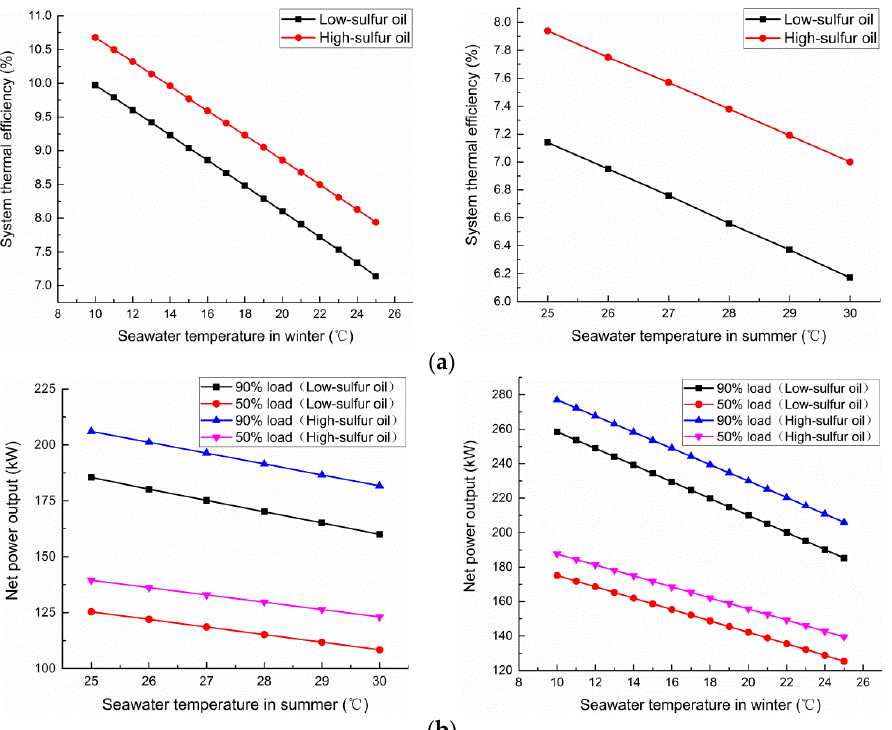
Figure 6. Variations in performance with seawater temperature for the jacket cooling water side ORC subsystem; ( a ) Thermal efficiency vs. seawater temperature in summer and winter; ( b ) Net power output vs. seawater temperature in summer and winter